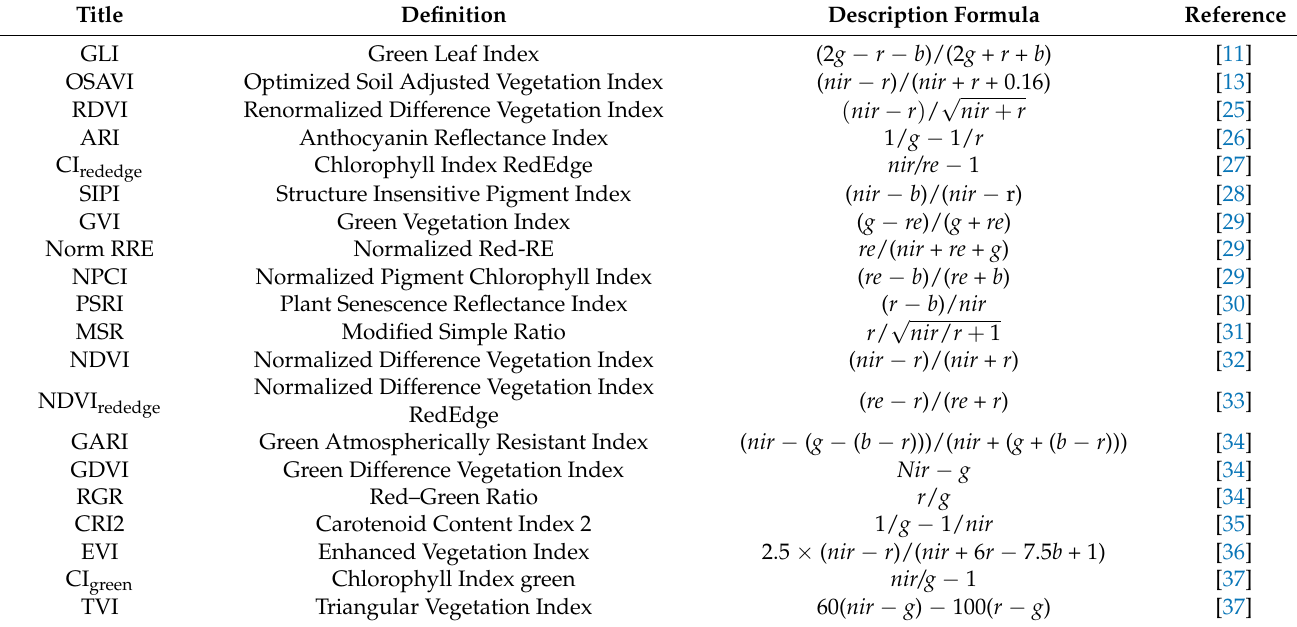
Table 2. Spectral vegetation indices used in this